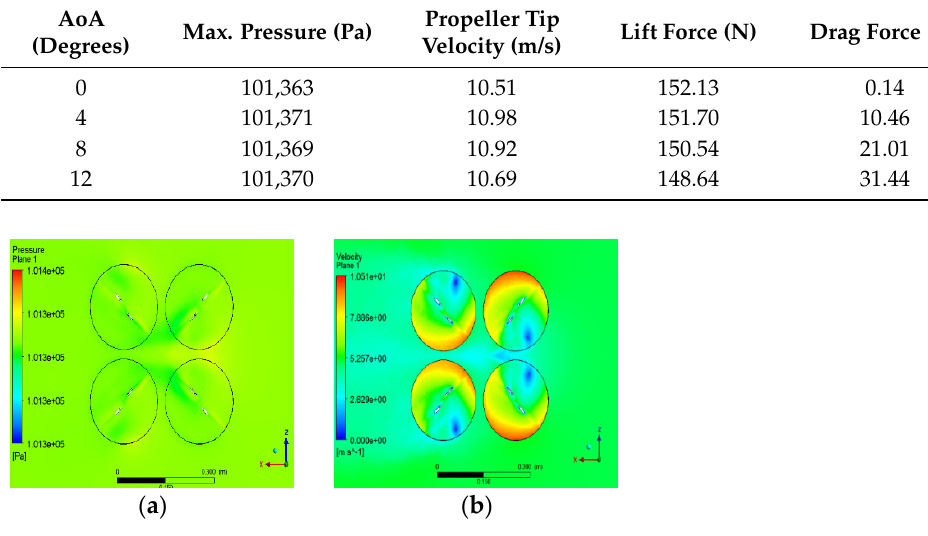
Figure 27. Forward flight of UAV. ( a ) Pressure at 0° AoA, ( b ) Velocity at 0° AoA. Table 14. Lift and drag force for different AoA during forward phase.